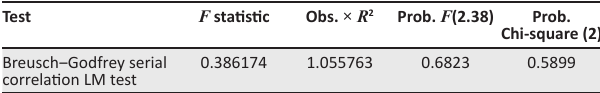
TABLE 10: Buffalo metro serial correlation test.